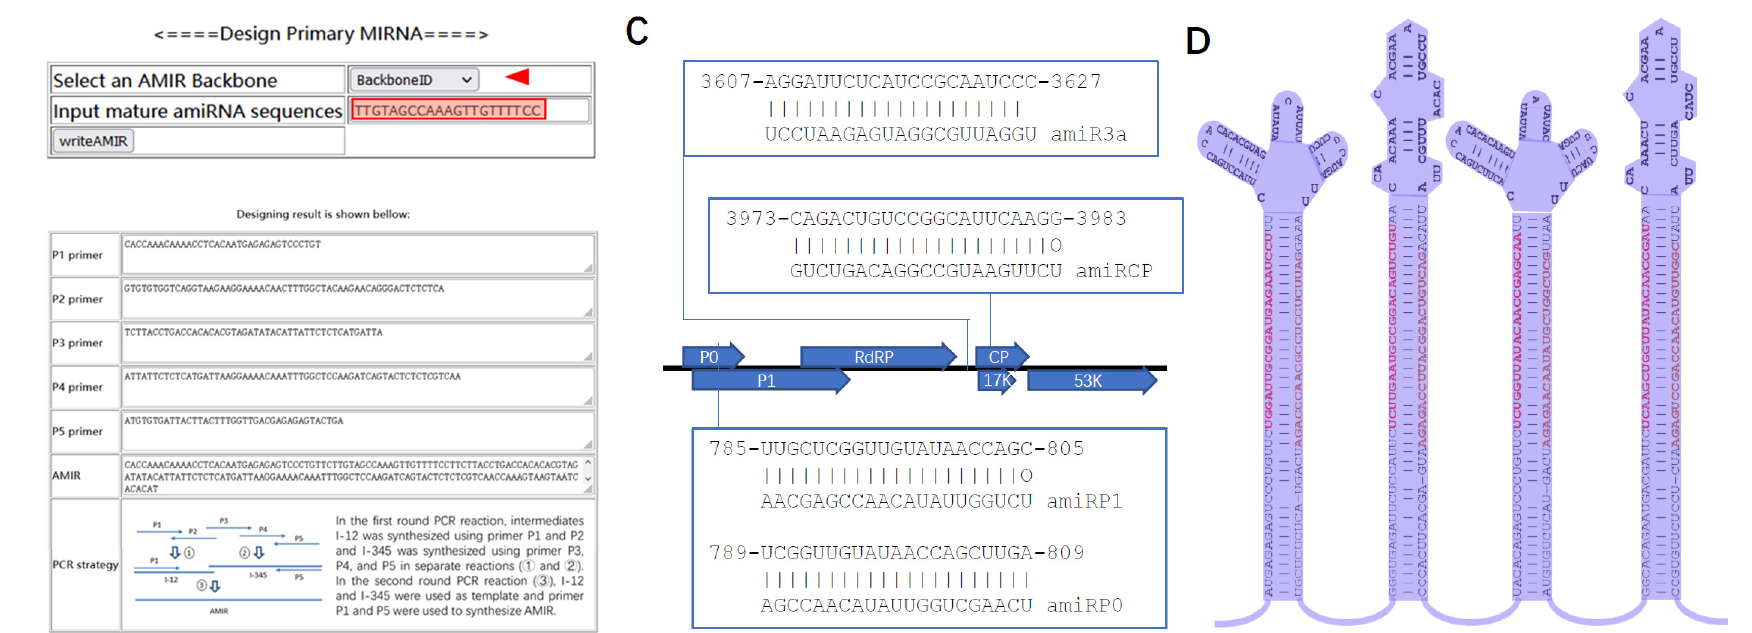
Figure 1. Interface of AMIRdesigner. ( A ) Homepage of AMIRdesigner. The red arrowhead points to the pulldown menu where users can select the backbone of the artificial miRNA; the textbox highlighted in red is where users can input their designed mature miRNA sequences of 21 or 22 nts in length. ( B ) Output from AMIRdesigner. Sequences of common primers specific to each backbone (P1, P3 and P5) and primers specific to each mature artificial miRNA (P2 and P4), as well as designed primary artificial miRNA (AMIR), are shown on the top rows. The PCR strategy using the designed primers to synthesize the designed AMIR is illustrated at the bottom. ( C ) AMIR target sites in the PLRV genome. The reference genome of D00530.1 was used. ”|” indicates a matched base while ”o” indicates a U-G wobble pair. 5 ′ U was used in all mature amiRNAs to facilitate their loading into the AGO1 protein. ( D ) Secondary structure of the designed PLRV targeting the AMIR cluster. Mature miRNA sequences are in red and bolded while miRNA* sequences are in dark yellow.